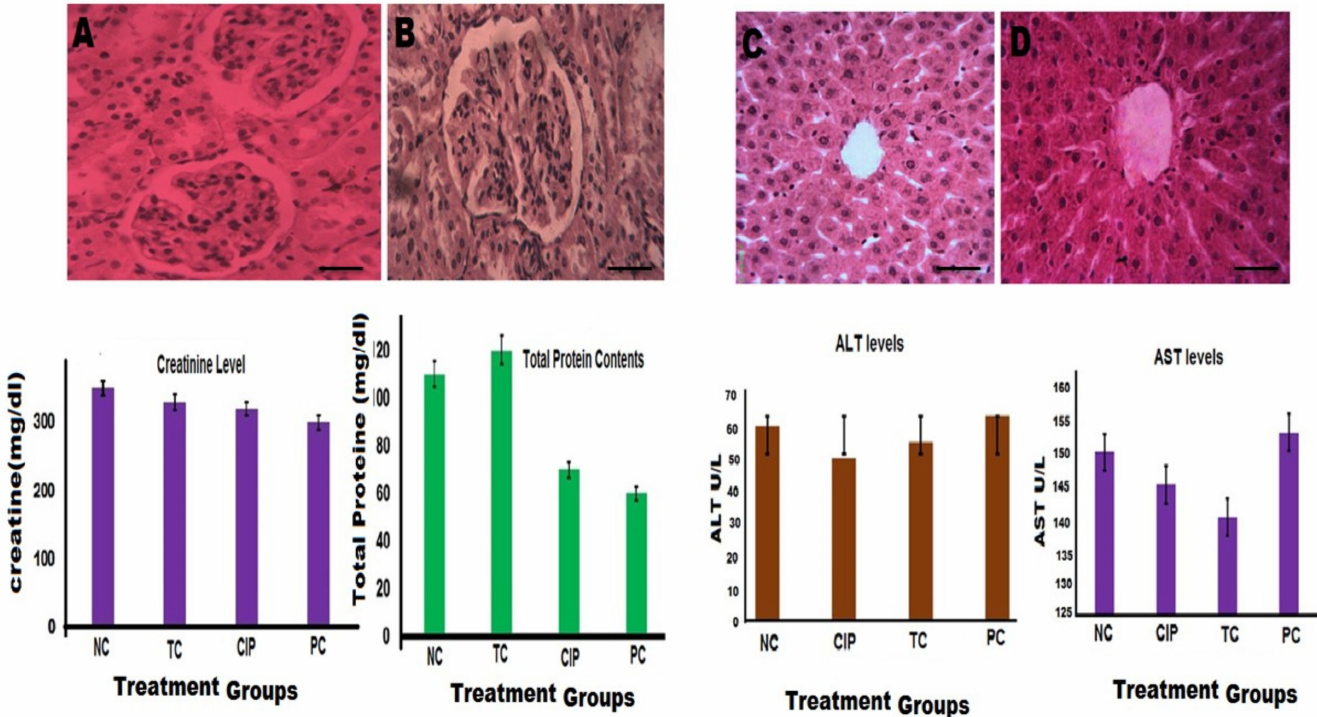
Figure 12. Endpoint effect of CIP-Ag/TiO 2 /Fe 2 O 3 /CS nanoformulation (NDDS) on the vital organs of a rabbit model of MDR E. coli -induced infection. ( A ) Cellular morphology of the renal tissue in NC = group 3 (non-infected and untreated, containing nutrient broth only); ( B ) cellular morphology of the renal tissue from group 4 (= CIP-Ag/TiO 2 /Fe 2 O 3 /CS NDDS; 0.004 µ g/kg body weight/day for 7 days); ( C ) cellular morphology of the hepatic tissue in NC (negative control) = group 3 (non-infected and untreated, containing nutrient broth only); ( D ) cellular morphology of the hepatic tissue from group 4 (= CIP-Ag/TiO 2 /Fe 2 O 3 /CS NDDS; 0.004 µ g/kg body weight/day for 7 days); NC; negative control (healthy group); PC: positive control (infected group without treatment); TC: Group treated with NDSS; CIP: group treated with ciprofloxacin (0.004 µ g/kg body weight/day for 7 days). p < 0.05 vs. CIP-treated group and PC. Histopathological sections of kidneys and livers of rabbits are shown with H&E staining at × 400 magnification. Bar scale represent 25 µ